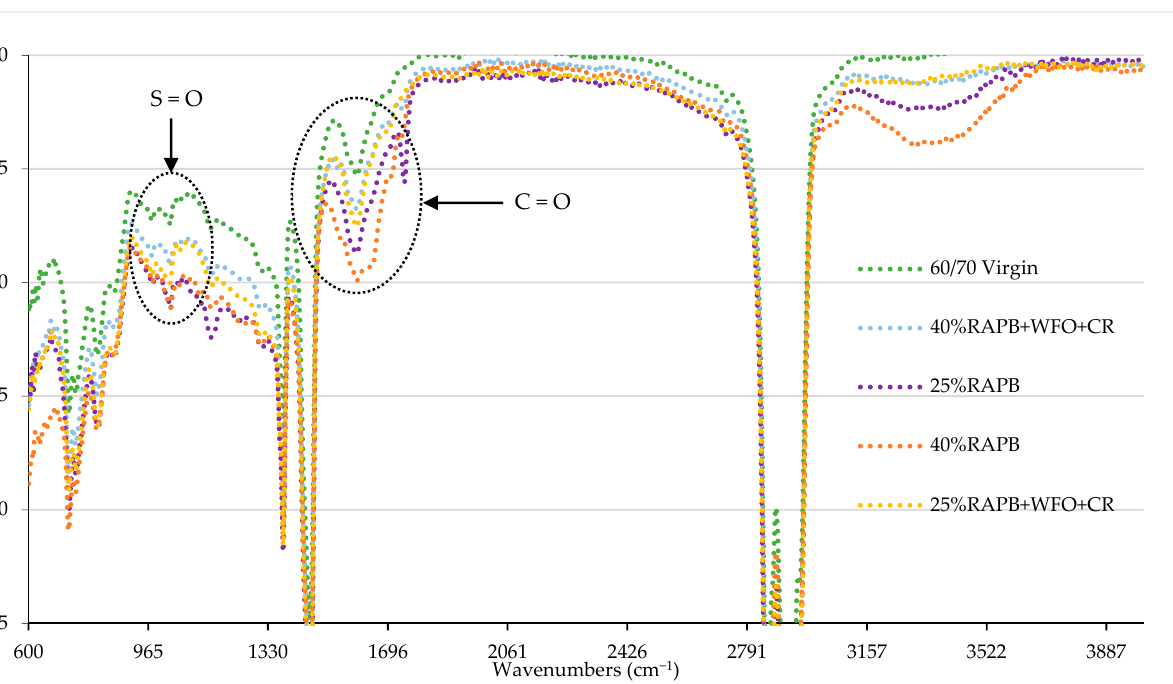
Figure 10. Results of FTIR spectra of the virgin, RAP, and recycled binders. The bands in the range of 1492-1700 cm − 1 were applied as an indicator to assess the relative oxidation of virgin, RAP, and modified binders. According to a previous study done by Tayh et al. [47], the peaks at 1700 cm − 1 represent carbonyl peaks C = O and increase with an increased amount of RAP dosage. The RAP with WFO and CR decreased the oxidation level at the band 1700 cm − 1 . It can be related to the addition of the WFO, which agrees with the previous study by Poulikakos et al. [48]. As can be observed in Figure 10, the binders containing 25 and 40% of RAPB have a higher sulfoxide group dosage than the virgin bitumen because the RAPB was exposed to the aging process, which increased the level of oxidation. These findings are similar to [49], who conducted a study on the impact of aging on the RAP with bio-based oil as a rejuvenator. In short, the addendum of the RAPB leads to an increase in the sulfoxide and carbonyl band [50]. The addition of WFO with CR reduces the sulfoxide group’s values, indicating a reasonable resistance to oxidation in the binder throughout the sulfoxide bond. It can be concluded that the ad- dendum of WFO softens the RAPB due to the excessive content of oxygen in WFO. The rejuvenation mechanisms of hybrid rejuvenated asphalts fundamentally concentrate only on the physical mixing [42]. Another study concluded that the oxygenated groups (C = O and S = O) reduced when the aged binder was blended with a rejuvenator, indicating the potential to rejuvenate the aged binder [51]. The RTFO was conducted to confirm no change in the chemical groups after the ag- ing process, representing the pressure and heat of bitumen during the mixing process. Figure 11 shows the results of a chemical group of the virgin, RAP, and recycled binders after short-term aging. The concentration of carbonyl, alcohol, ether, and ester slightly decreased, indicating the loss of lightweight particles for binders with 25 and 40% RAP. Meanwhile, both the virgin and modified binders had slightly increased concentrations of the carbonyl bond and sharply increased sulfoxide content due to the oxidation process of RTFO. The results of short-term aging and its effects on the chemical groups are similar to the previous study done by Tayh et al. [47].